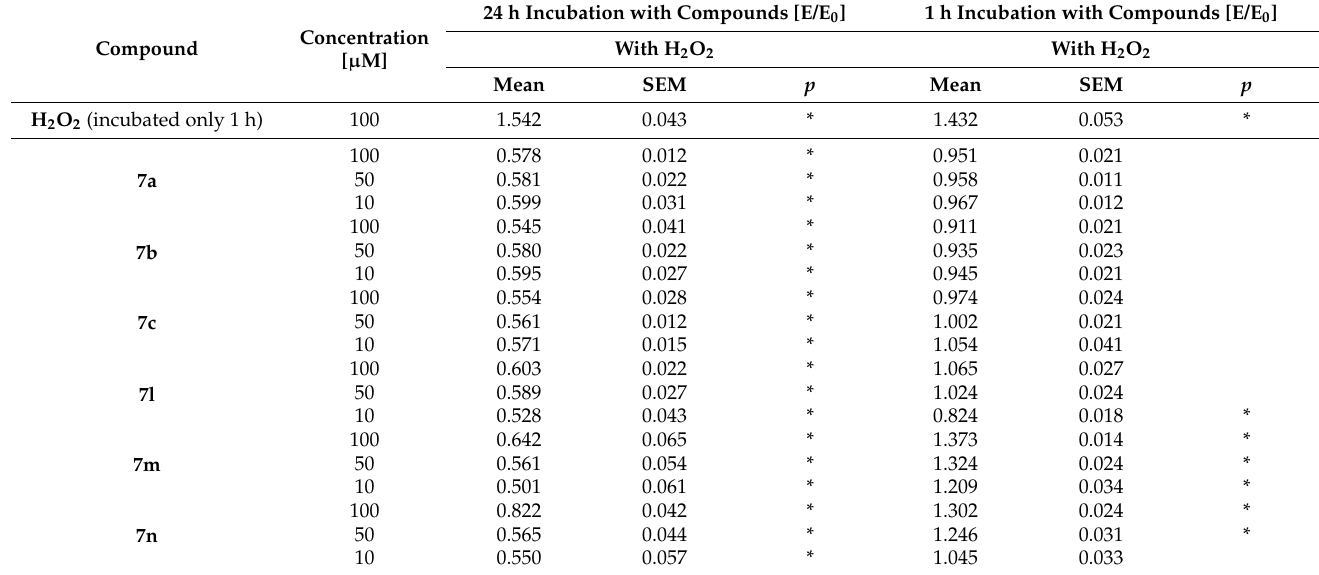
Table 6. DNA damage evaluation after incubation with tested compounds [mean (SD); n = 3]; the results were compared to the control and expressed as E/E0 ratios; statistical significance calculated with post hoc test compared to the control (* p < 0,05; E0—cultures without tested compounds).